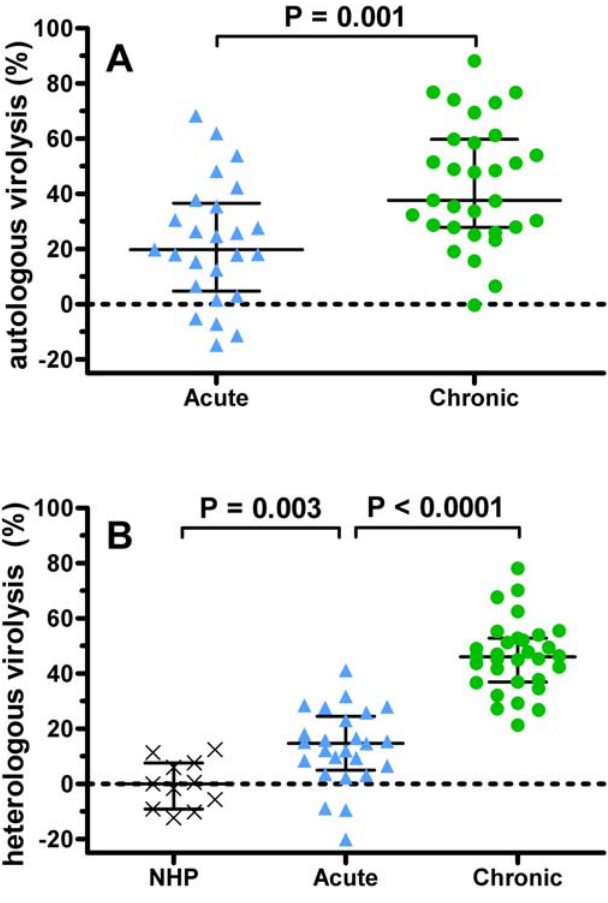
Figure 3. Lysis Activity against Virus in Plasma of Acutely and Chronically Infected Patients Complement-mediated lysis activity against autologous (A) and heter- ologous (JR-FL) (B) virus was compared between acutely (blue triangles) and chronically (green circles) infected individuals. HIV-specific lysis activity is present at acute and chronic diseases stages but generally higher during chronic infection. Crosses denote uninfected plasma controls. Groups were compared using Mann-Whitney U